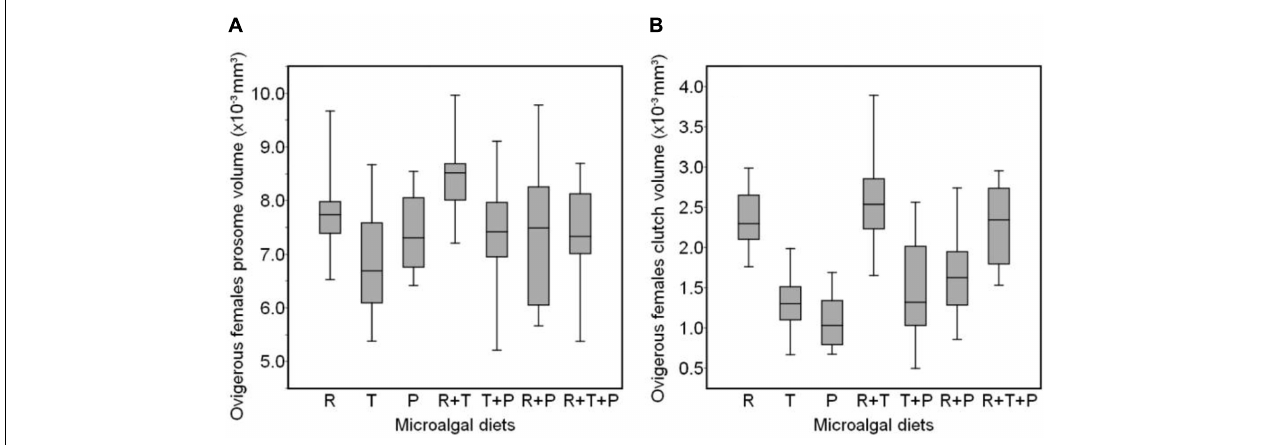
FIGURE 2 | Boxplot showing the distribution of prosome volume (A) and clutch volume (B) of Paracyclopina nana ovigerous females fed on different microalgal diets. Shaded boxes represent the first and third quartiles with the middle bar indicating the median. The end of the whiskers extends from the hinge to the lowest and highest value within a 1.5 inter-quartile range. R, Rhodomonas salina; T, Tisochrysis lutea; P, Pavlova lutheri.